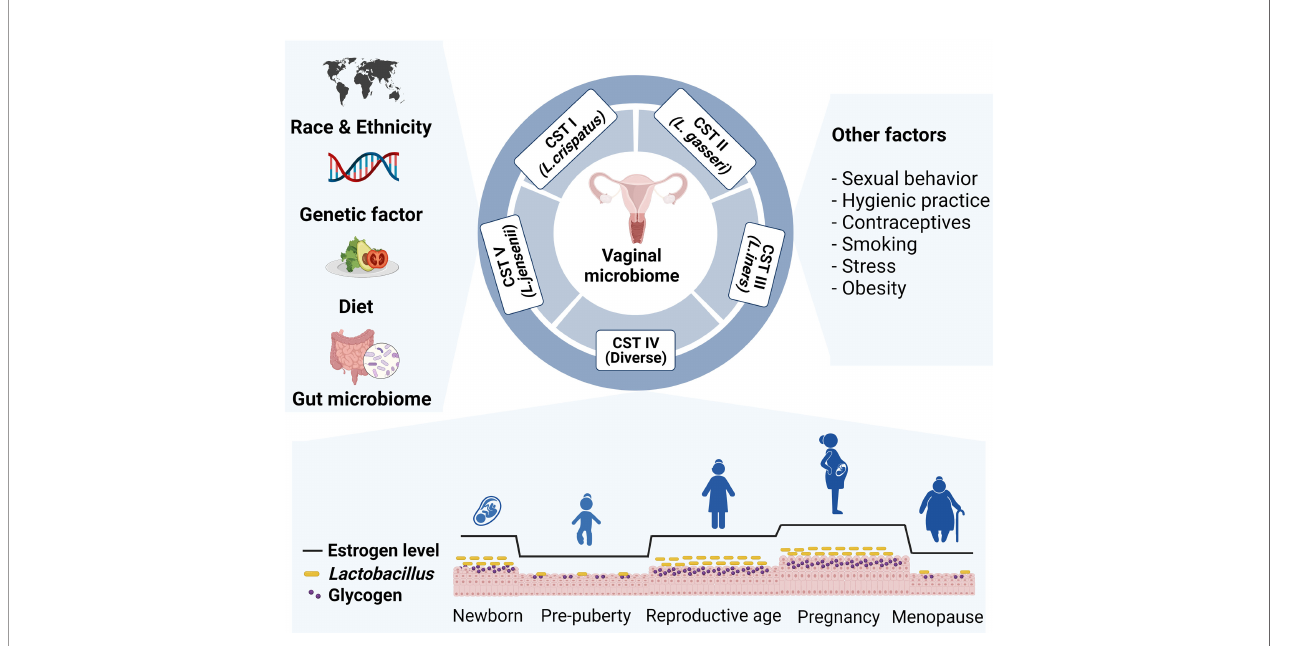
FIGURE 1 | Various intrinsic and extrinsic factors that affect vaginal microbial community. The composition of the vaginal microbiome differs across host predisposing factors, such as race, ethnicity, and genetic variation. Lifestyle factors including diet, sexual behavior, hygienic practice, contraceptives, smoking, stress, and obesity also affect vaginal microbiome composition. Particularly, Lactobacillus abundance changes by level of glycogen, which deposits in epithelial cells upon estrogen stimulation. Prepubertal girls and postmenopausal women have relatively low abundance of lactobacillus